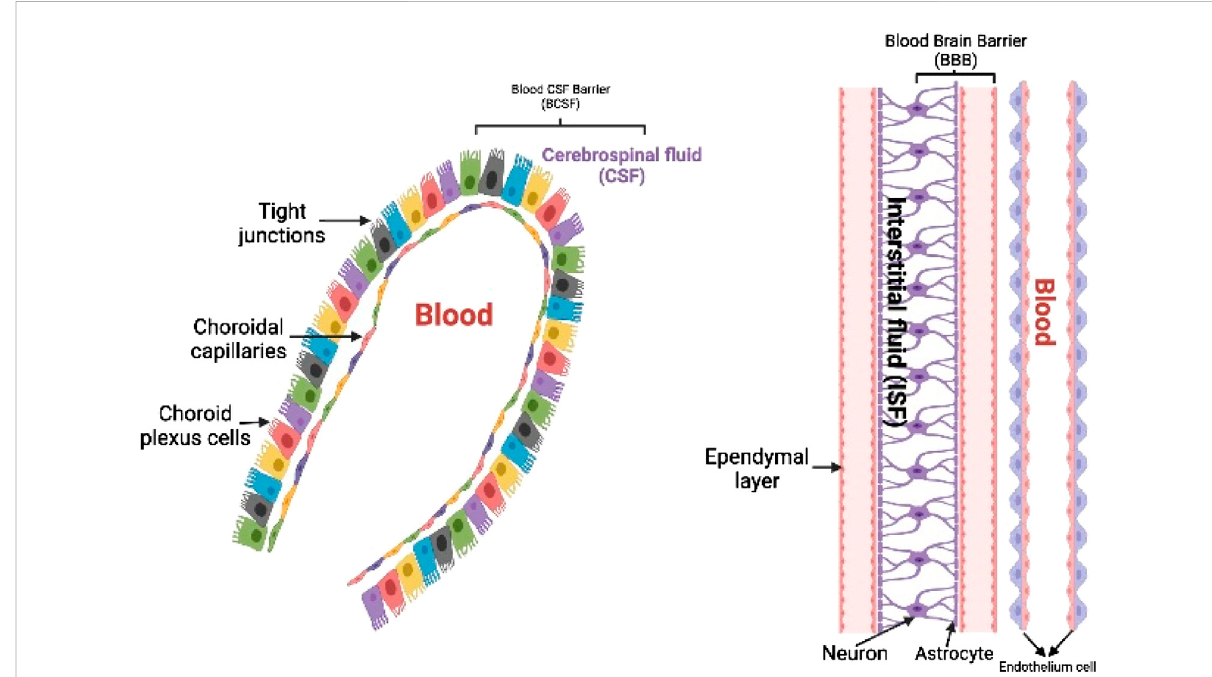
FIGURE 2 ynopsis of the blood – brain and blood – cerebrospinal fl uid barriers. The blood – cerebrospinal fl uid (CSF) barrier, which stops substances from traveling paracellularly into or out of the brain, is made up of tightly connected choroid plexus epithelial cells. Additional chemical barriers exist to stop substances from entering the central nervous